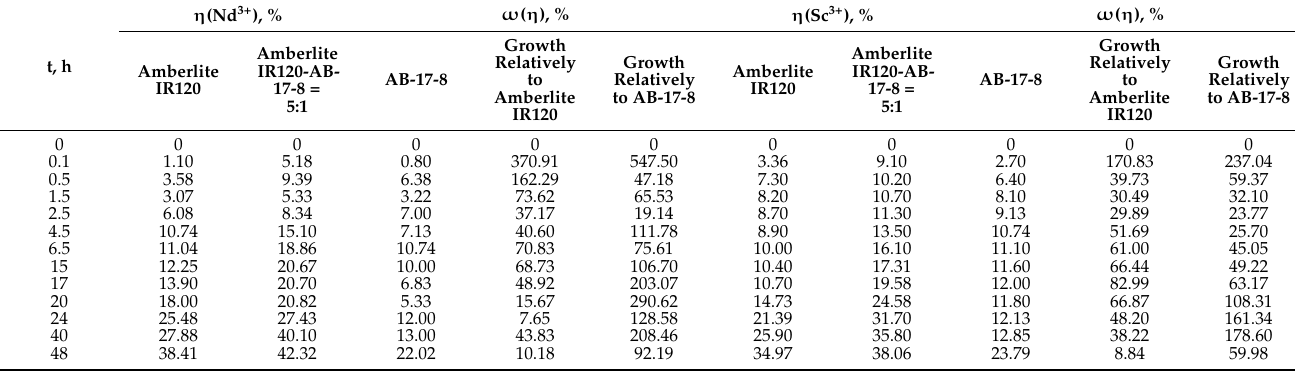
Table 1. Increase of extraction degree (in relation to Nd 3+ and Sc 3+ ions) in interpolymer pair Amberlite IR120:AB-17-8 = 5:1 comparatively with individual ion-exchange